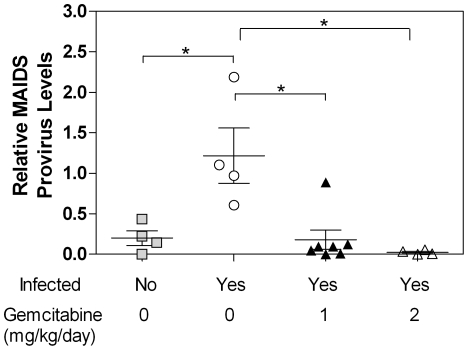
Provirus levels in mice infected with LP-BM5 MuLV.Genomic DNA was extracted from mouse spleen and quantitative real time PCR was performed to detect the defective MAIDS provirus. Provirus levels were normalized to the 18S rRNA gene. Each symbol (squares, circles, and triangles) represents one animal. The Pfaffel modification of the ΔΔCt method was used to assess gene expression. Statistical significance was assessed by One-Way ANOVA with Tukey-Kramer post-test with p<0.05 designated as significant.